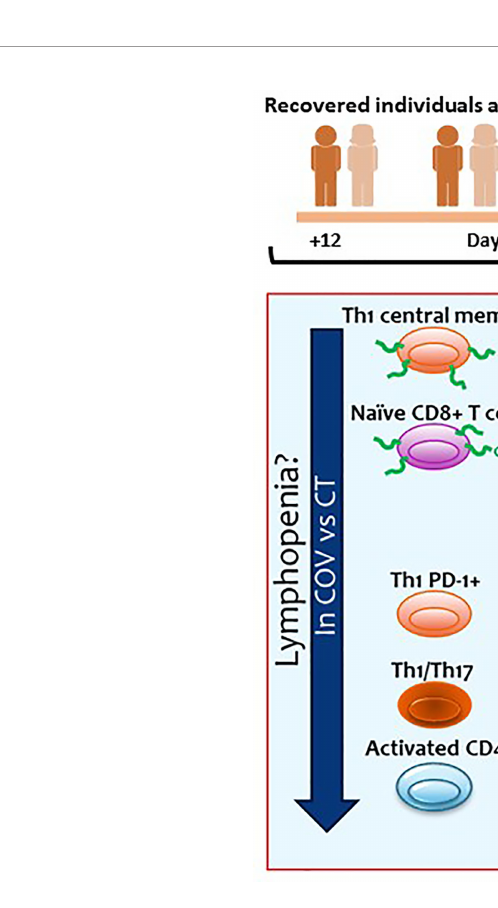
FIGURE 6 | Summary of the results obtained in the present study. Orange and green individuals represent the recovered individuals after SARS-CoV-2 infection and controls, respectively. Numbers represents the days post-PCR+ when the samples of the former COVID-19 individuals were analysed. Blue squares represent the cellular subsets with altered levels observed in the periphery. Orange square represents the cellular subsets that could be potentially found in tissues or